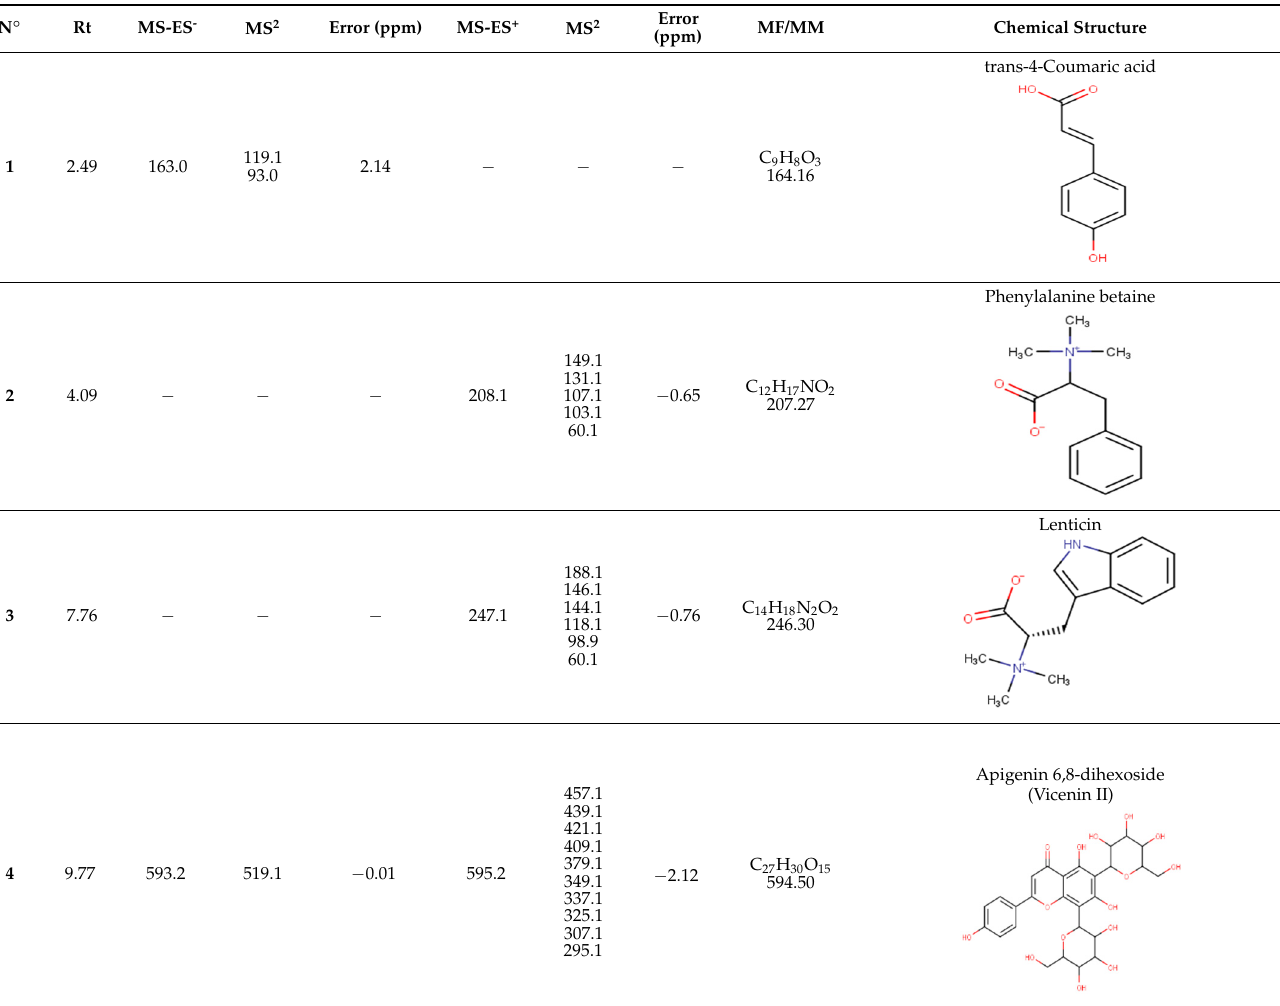
alkaloids, and fatty acid amides. Compounds 14, 15, 17, and 18 correspond to new com- pounds, and to verify their structures, they should be isolated and analyzed using spectro- scopic techniques (nuclear magnetic resonance of proton and carbon). Table 1 indicates the m / z values of the ions detected by full ESI-MS (positive and/or negative) and the fragments obtained by MS/MS for each of them; the error (in ppm) of the calculation is also indicated for the molecular formula ( ≤ 5 ppm). Figure 2 shows total ionic current chromatograms (TIC) for the samples, identifying the compounds via their respective retention times. Some compounds identified in the latex have been identified in other species of the Apocynaceae family, such as phenolic acid-like trans-4-coumaric acid and para-coumaric acid in Carissa carandus [12]. However, some of the tentative structures determined in the chromatographic analysis differed from other Himatanthus species, i.e., plumieride, an iridoid representative of this plant [13], lupeol, two isomers of amyrin, β -sitosterol, and proteins isolated from Himatanthus drasticus latex [5]. α -amyrin, lupeol, and lupeol acetate were also determined in the hexane fraction of H. sucuuba latex [14], and spirolactone iridoids such as plumericin and isoplumericin were identified in the ethanol extract of H. sucuuba stem bark [15]. Furthermore, in the non and polar fractions of the stem bark, iridoids such as plumeridoid C, plumericin, plumieridin, and allamandicin were also identified, as were other flavonoidal structures such as dihydrocajanin, naringenin, Table 1. Tentative chemical components identified by UPLC-ESI-MS/MS of H. sucuuba latex. N° Rt MS-ES -